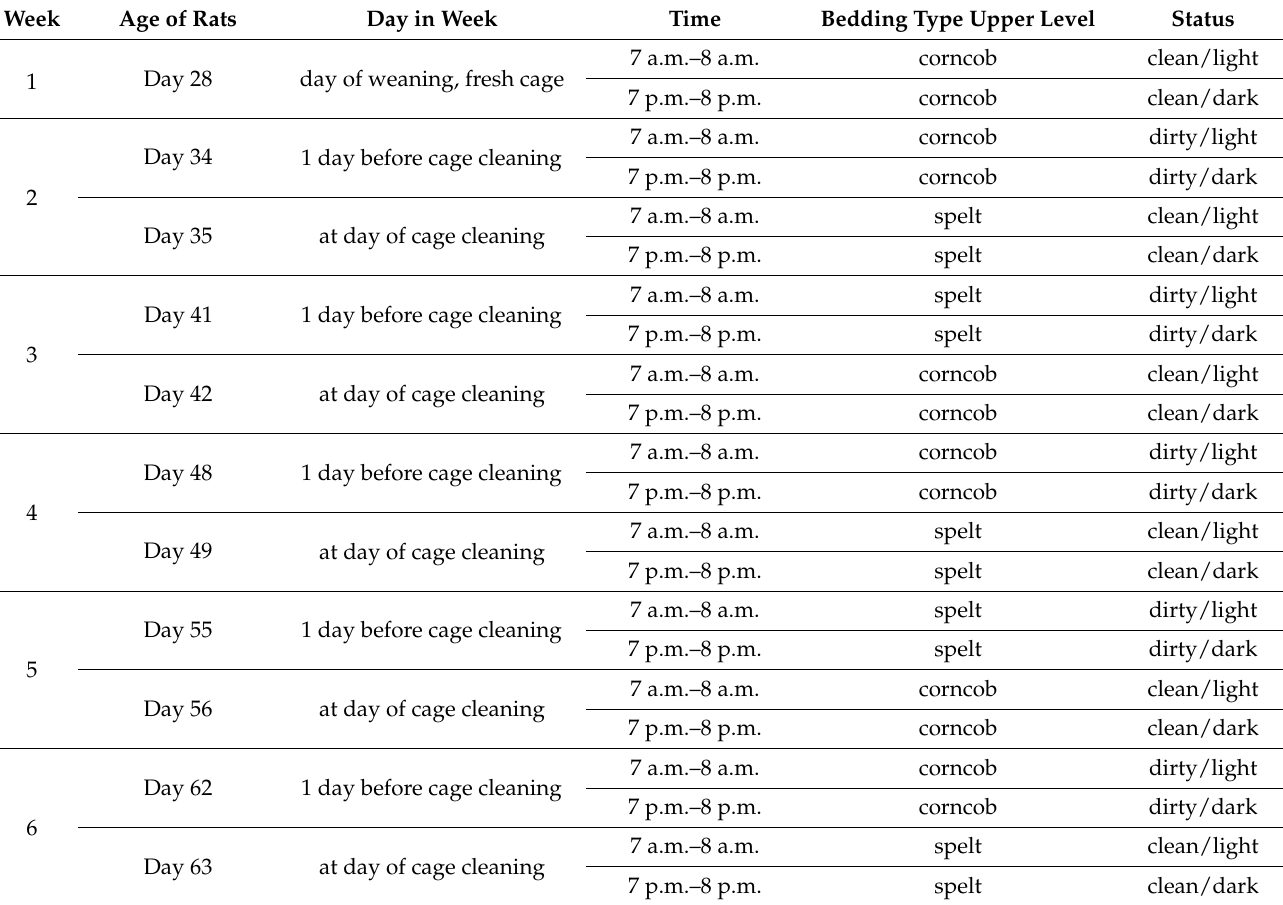
Table 2. Time points for the assessment of the preference behavior (‘rat index’) in the preference cages. The analyses of preference behavior started with weaning, when the rats were placed in the new fresh preference cage. The rats were videotaped four times a week, except for Week 1 (no ‘dirty’ condition) and Week 6 (no ‘clean’ condition). n = 1 cage per sex (with 6 rats in each